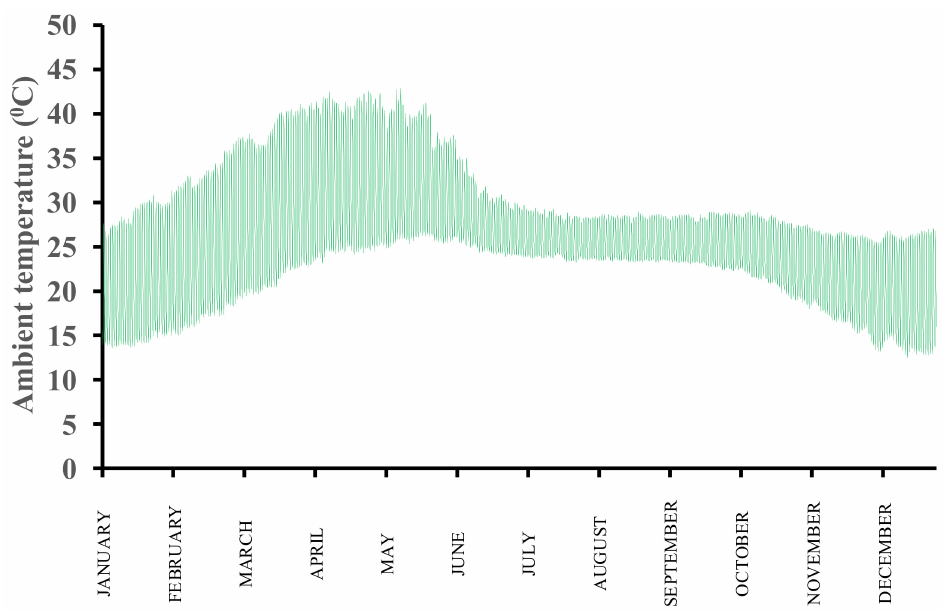
Figure 6. The annual ambient temperature of the study